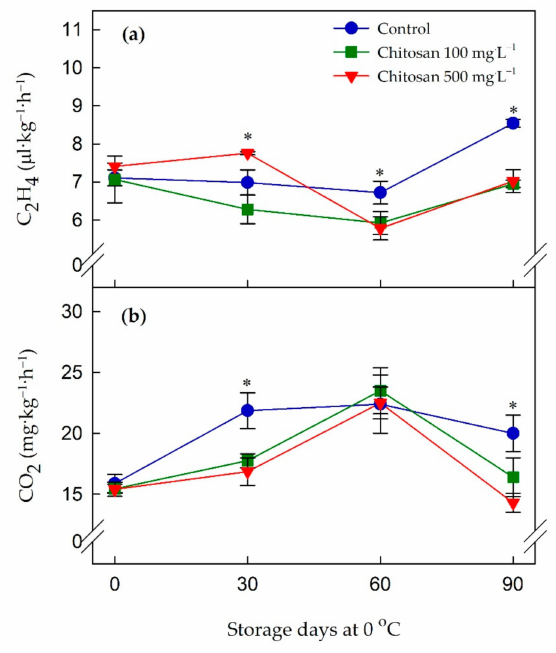
Figure 1. Effects of preharvest chitosan application on ( a ) ethylene production and ( b ) respiration rates during cold storage in ‘Garmrok’ kiwifruit. Vertical bars indicate SE with n = 3. * indicates significant differences between treatments at each sampling date, according to the least significant difference (LSD) test at p ≤